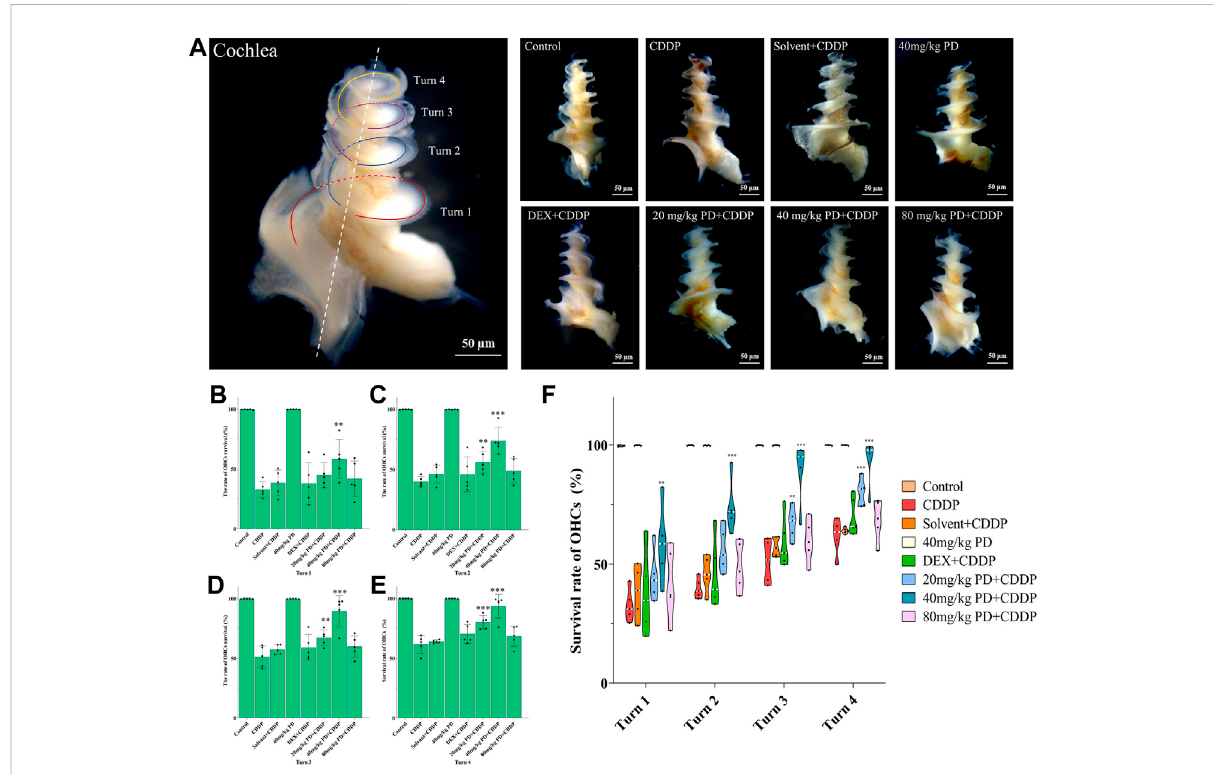
FIGURE 4 PDcouldreduceOHCslossaftercisplatinadministration. (A) Thecochleaofguineapigswasdividedinto4turns,andthebasilarmembranewas dissected from them, and then stained and counted. Scale bar, 50 μ m. (B) In turn 1, only the 40 mg/kg PD + CDDP group could improve the survival rate of OHCs compared with that of the CDDP group, p = 0.001. (C) , (D) and (E) In turn 2, turn 3, and turn 4, compared with the CDDP group, both 20 mg/kg PD + CDDP and 40 mg/kg PD + CDDP groups could improve the survival rate of OHCs, and the 40 mg/kg PD + CDDP group presented a better protective effect on OHCs than that of the 20 mg/kg PD + CDDP group ( p = 0.003, p < 0.001 and p = 0.002 for turn 2, turn 3 and turn 4, respectively). (F) Graph shows the survival rate of OHCs after drug administration in each group. Either cisplatin or PD, the survival rate of OHCs always increases gradually from turn 1 to turn 4. n = 5. Data are presented as mean ± SEM. ** p < 0.01, and *** p < 0.001, all versus the CDDP